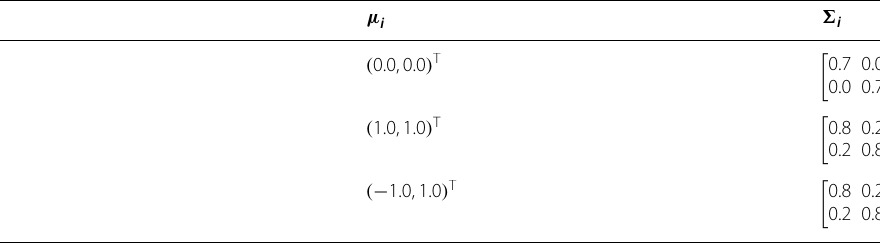
Table 1 The mean vectors and covariance matrices of three Gaussian distributions in Gaussian1 i µ i (cid:31) i 1 ( 0.0,0.0 )